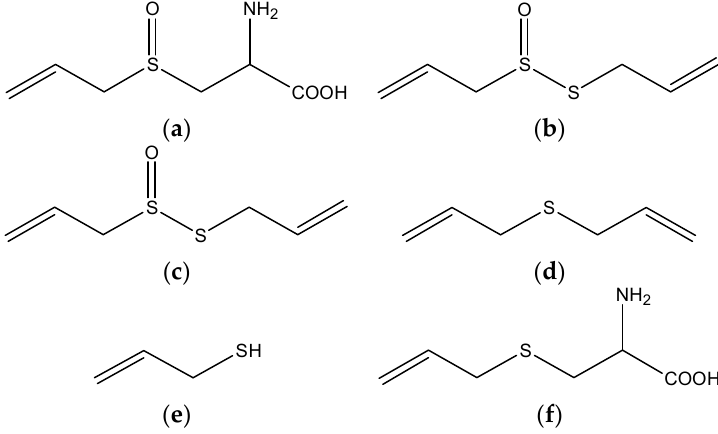
Figure 2. The chemical structures of several organo ‐ sulphur compounds in garlic: ( a ) alliin; ( b ) allicin; ( c ) diallyl disulfide; ( d ) diallyl sulfide; ( e ) allyl mercaptan; and ( f ) S ‐ allylcysteine.